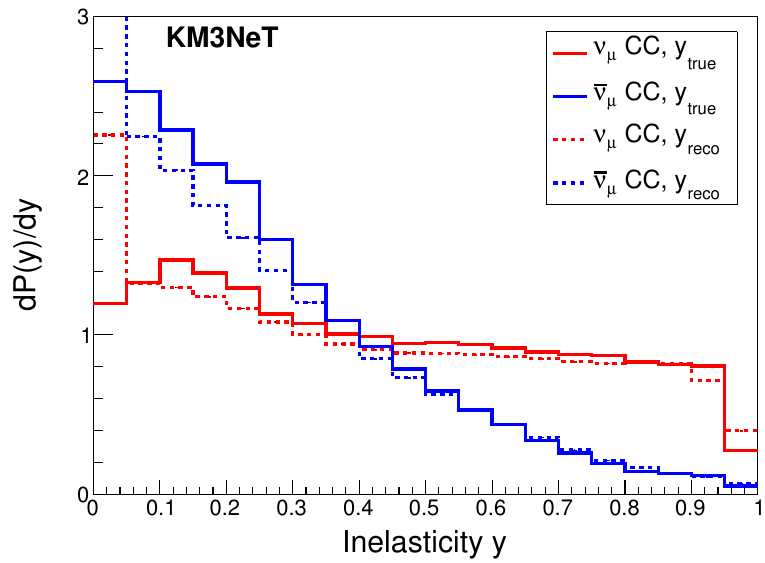
Figure 17 . Probability density distributions, P , of inelasticity y true (solid) and y reco (dashed) for (cid:23) (cid:22) (red) and (cid:23) (cid:22) (blue) CC events with E (cid:23) = 5 GeV. The dip in the last bin (as y ! 1) is caused by the (cid:12)nite muon mass. Due to a fraction of low-energy hadronic cascades producing very few photons, the y reco distribution is shifted to the left, causing the excess in the (cid:12)rst bin (as y reco !